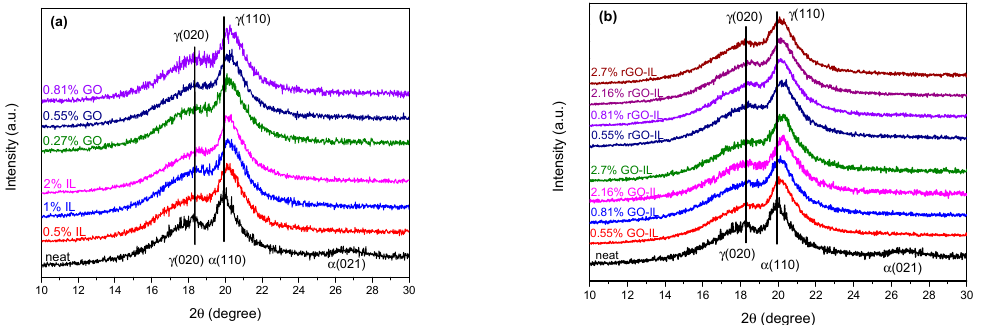
Figure 11. XRD patterns of neat P(VDF-CTFE) and composites with IL and GO ( a ) and GO-IL and rGO-IL ( b ).